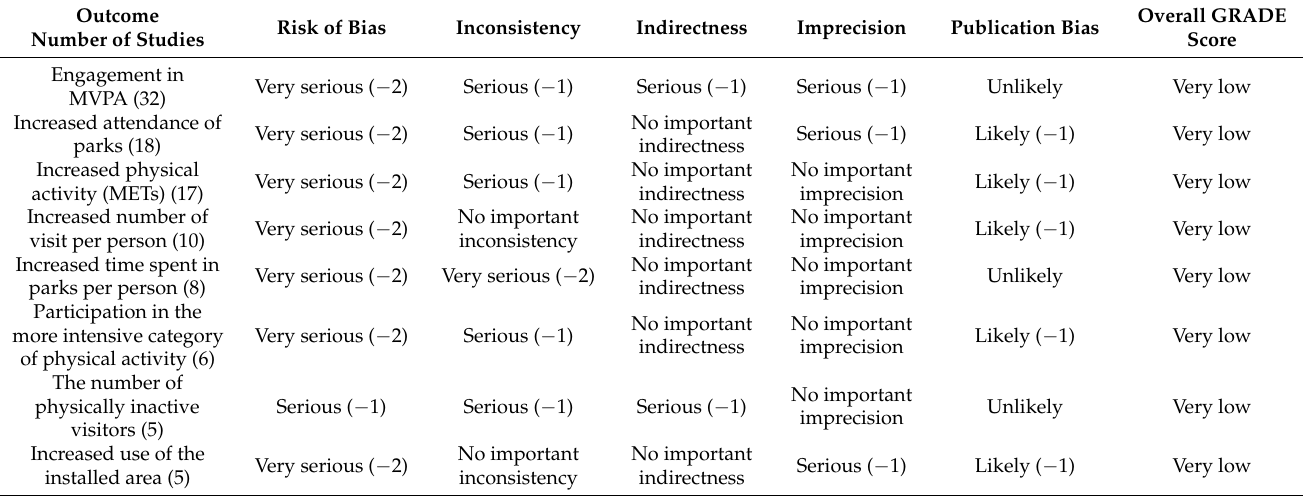
Table 7. Assessment of quality of studies using the GRADE